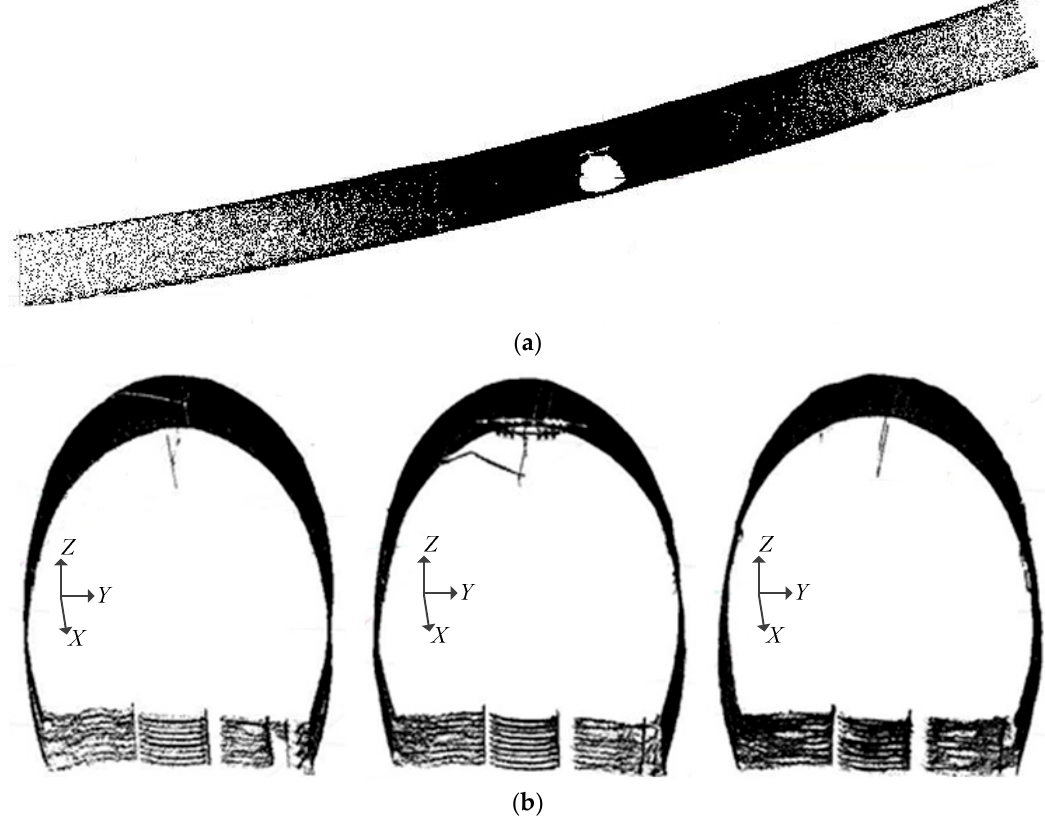
Figure 3. Segmentation results of tunnel point cloud. ( a ) Top view of whole tunnel point cloud; ( b ) point cloud of three segments.